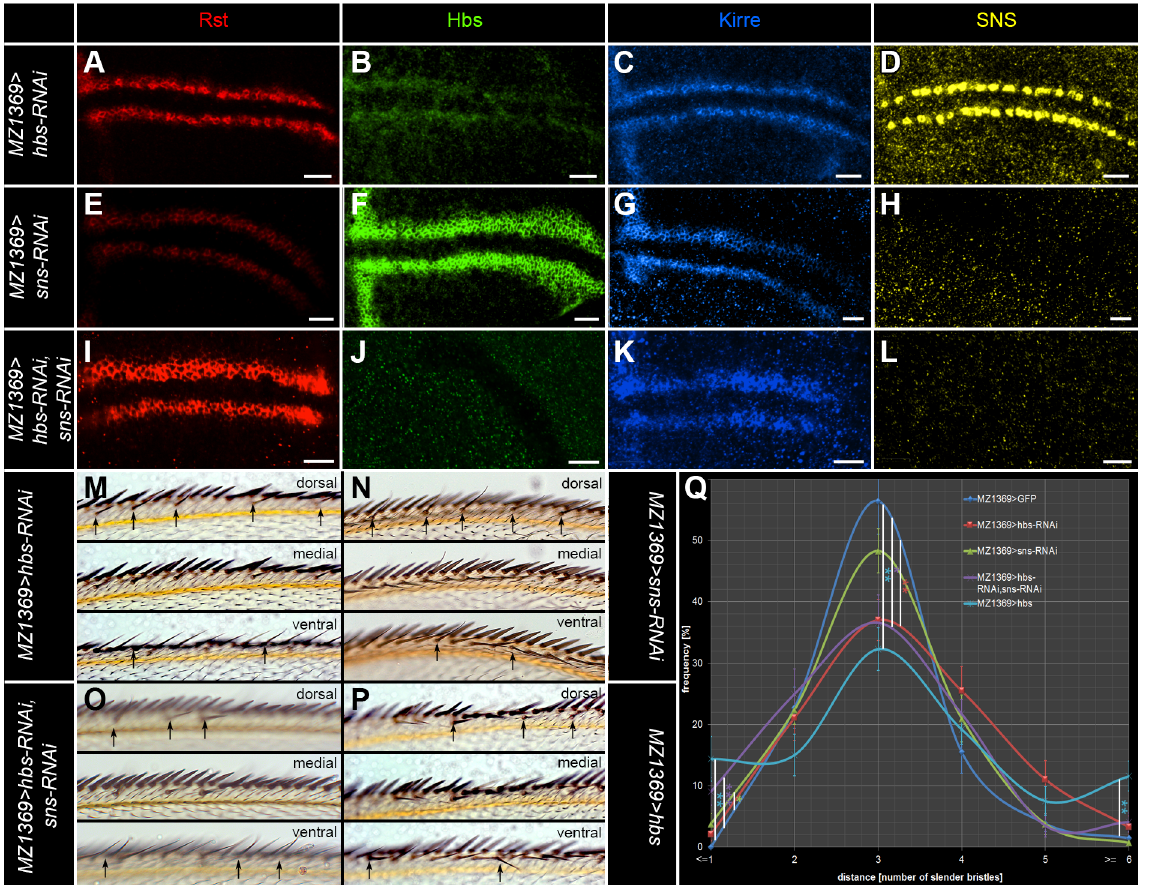
Fig 3. Hbs acts cooperatively with SNS to secure the bristle pattern in the anterior wing margin. (A-L) Projection views of IRM-protein immunoreactivity in late third instar larvae. Rst is shown in red (A, E and I), Hbs in green (B, F and N), Kirre in blue (C, G and K) and SNS in yellow (D, H and L). (A-D) Global hbs-RNAi using MZ1369-GAL4 reduces the staining for Rst (A) and Kirre (C) in all membranes that are not in contact to the SOPs (B) Hbs immunoreactivity is reduced and no clear membrane localization is detectable. (D) SNS immunoreactivity is only mildly affected, but SOPs stand